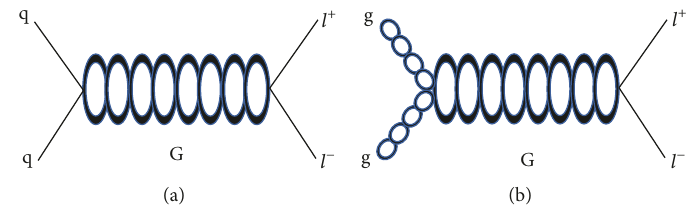
Figure 2: Processes for the graviton resonance production through (a) quark-quark and (b) gluon-gluon